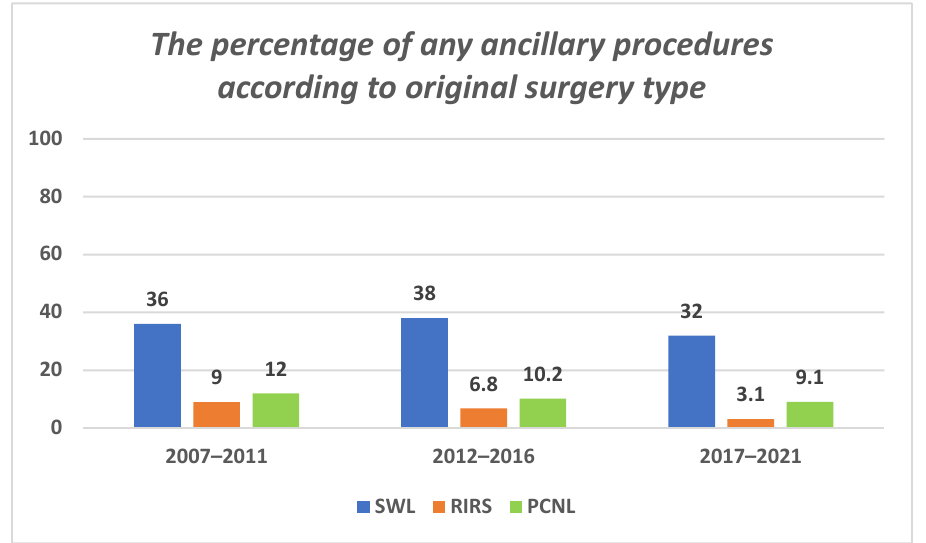
Figure 2. Any ancillary procedures according to the original surgery type.